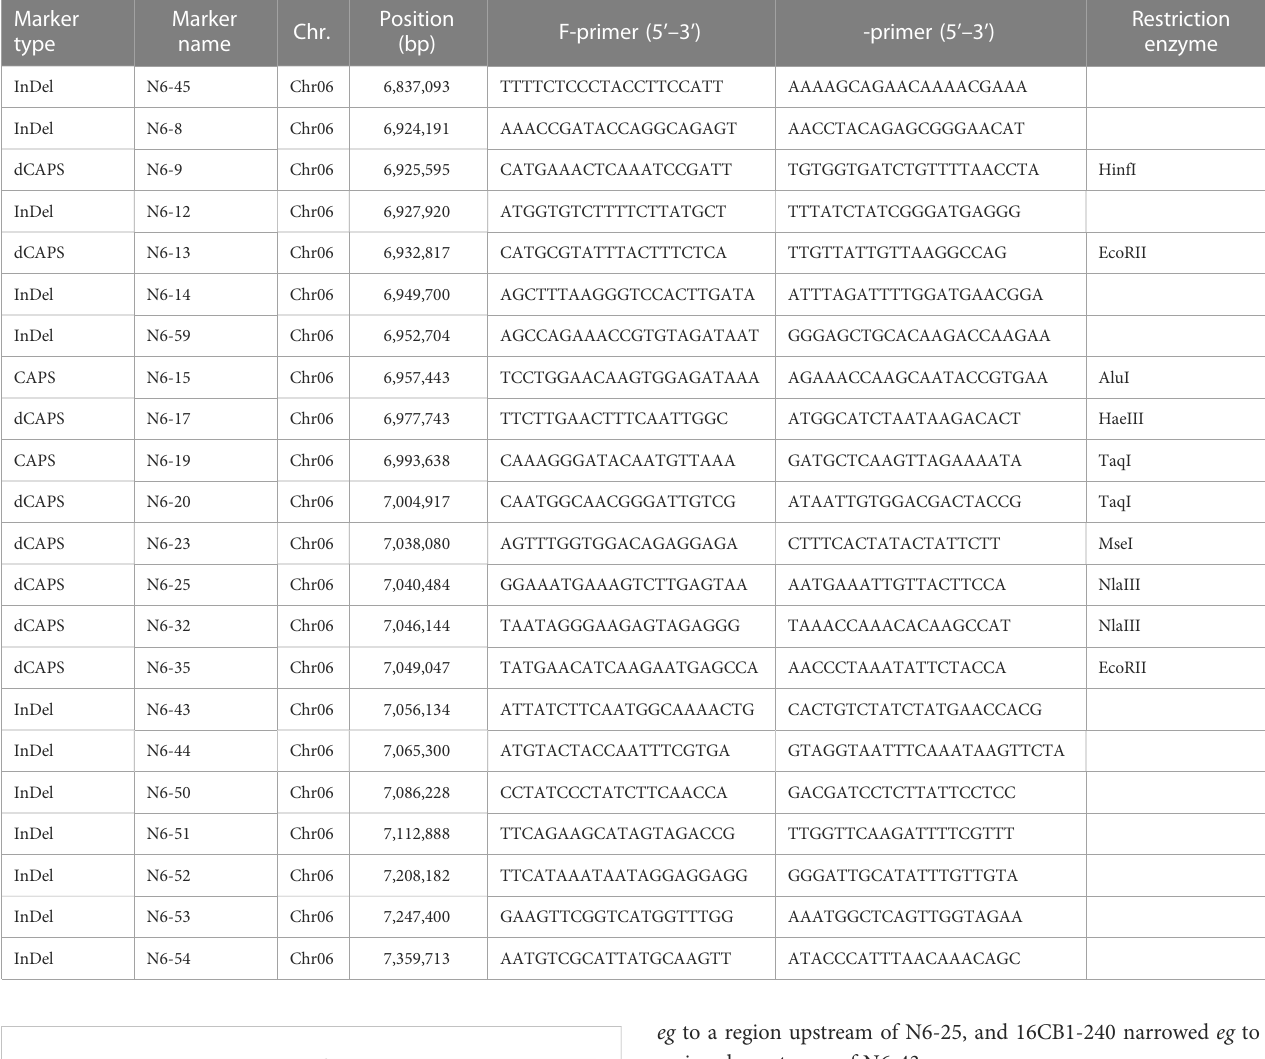
TABLE 3 The details for the PCR-based markers.